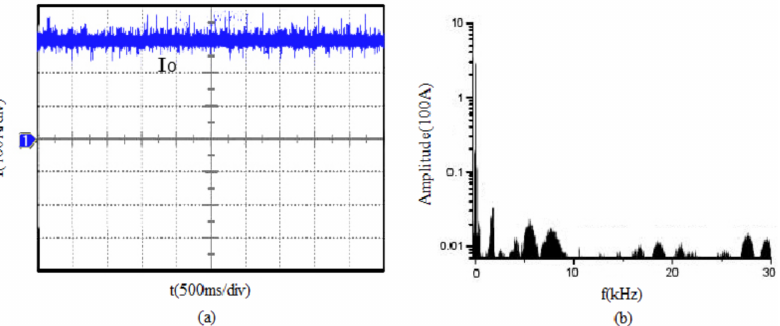
Figure 25. The experimental current waveforms of DC power generation: ( a ) output current wave- form; ( b ) output current spectrum.